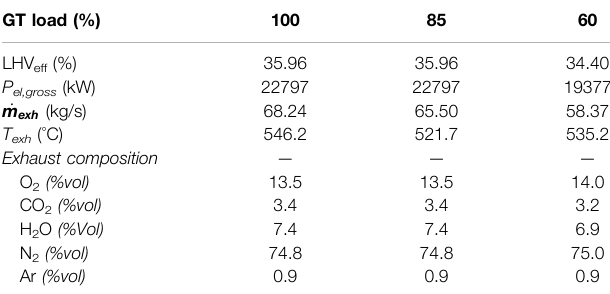
TABLE 1 | Reference GT data for the LM2500 PJ model in the reference platform at full load and three off-design part load operating conditions. GT load (%)